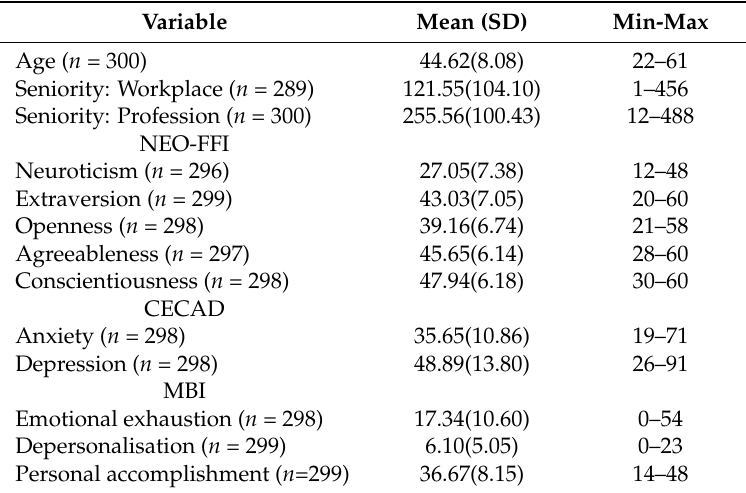
Table 2. Descriptive data for the quantitative study